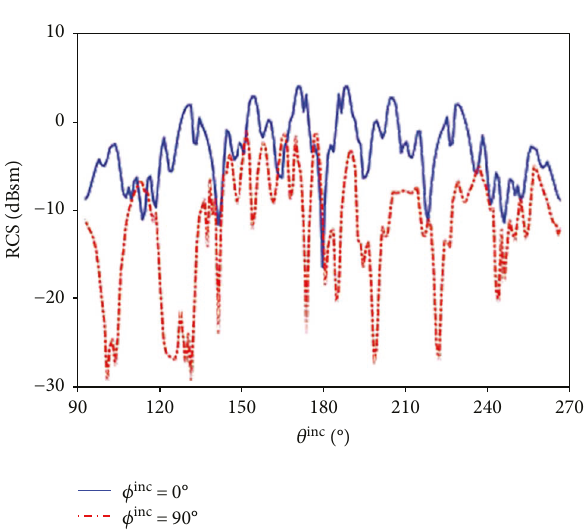
Figure 14: Value of the minimum RCS ( α = 90